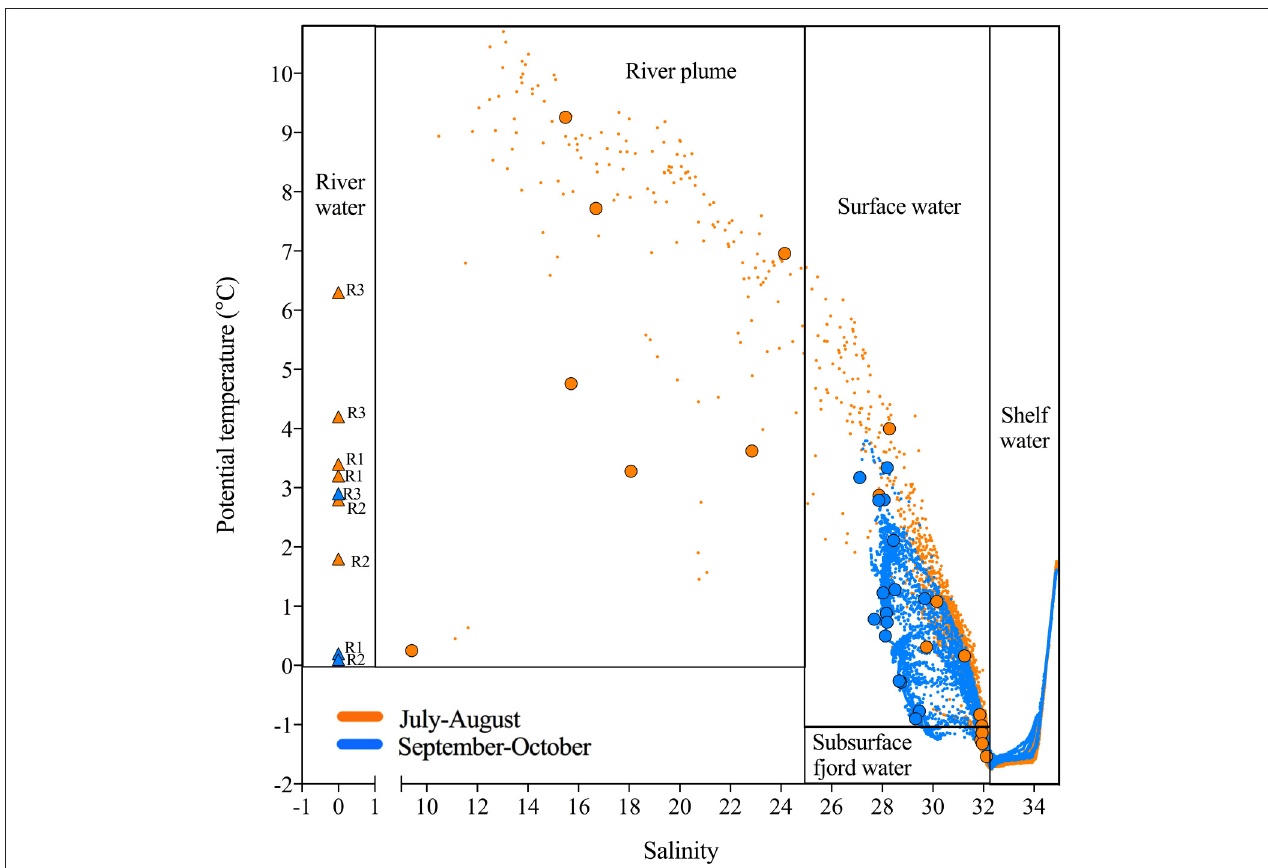
FIGURE 2 | Potential temperature ( θ ) and salinity plot for the open-water season in Young Sound 2014 with water types divided into five categories following the criteria presented in Table 1 and selected based on salinity and temperature profiles ( Figure S1 ): River water, River plume, Surface water, Subsurface fjord water, and Shelf water. The season is split into two periods: July-August (orange) and September-October (blue). All data points from CTD casts throughout the fjord is shown as small triangles, while larger symbols (circles and triangles) represent the “focus depths” which include measurements of bioavailability, particle associated production and bacterial community composition. The river samples (triangles) are labeled according to origin; Tyroler river (R1), Clay Bay river (R2), and Zackenberg river (R3) and their salinity is set to 0.